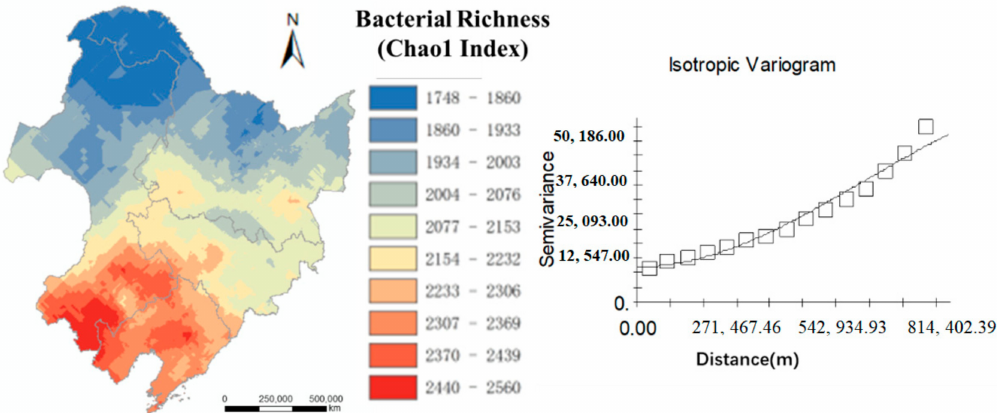
Figure 4. Spatial distribution of the Chao1 index in the black soil area. The colors indicate the extrapolated values expressed as Chao1 per soil sample. In the graph, the points represent the experimental variogram and the continuous lines are the Gaussian models fitted by